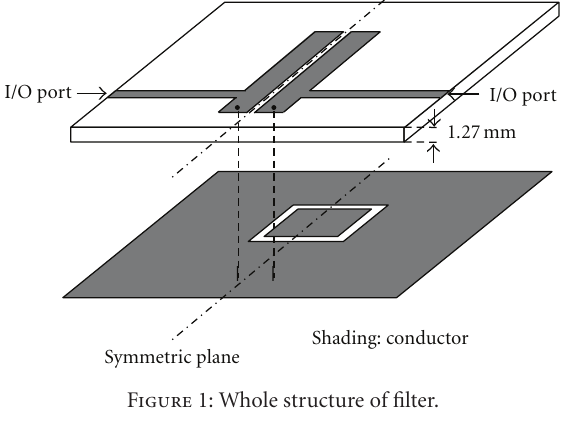
Figure 1: Whole structure of filter.